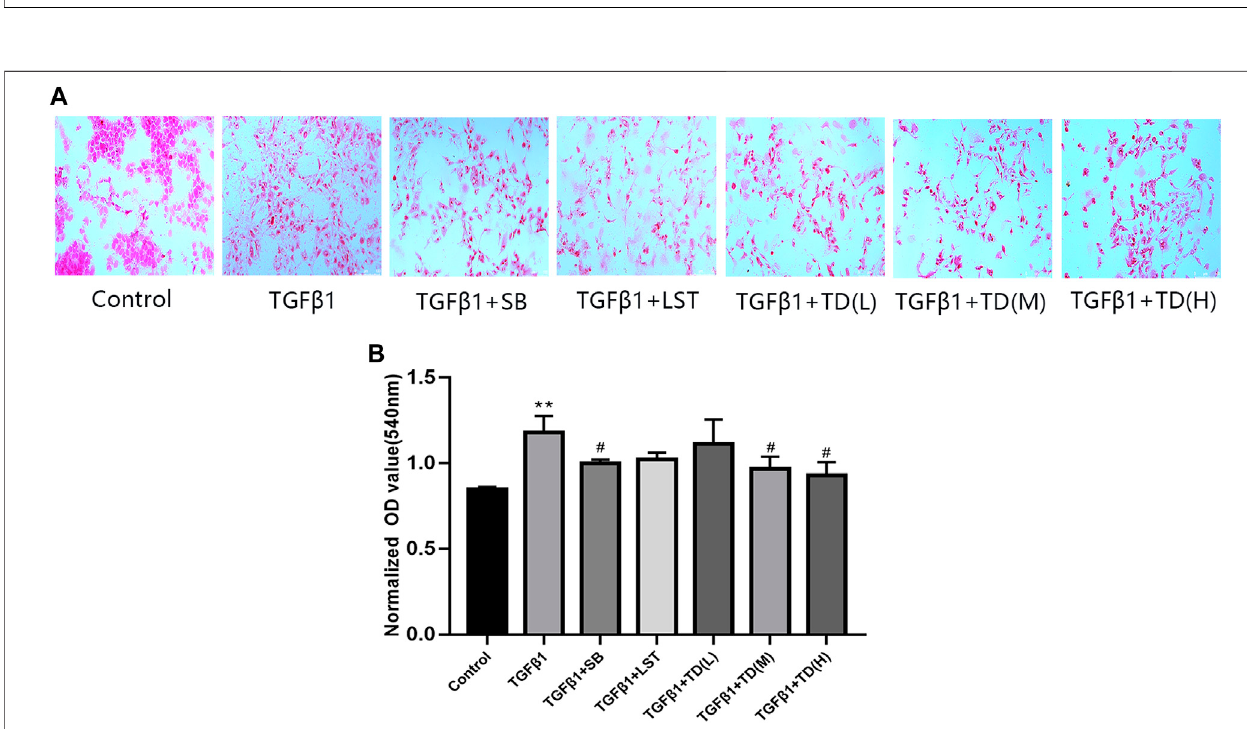
Frontiers in Pharmacology |